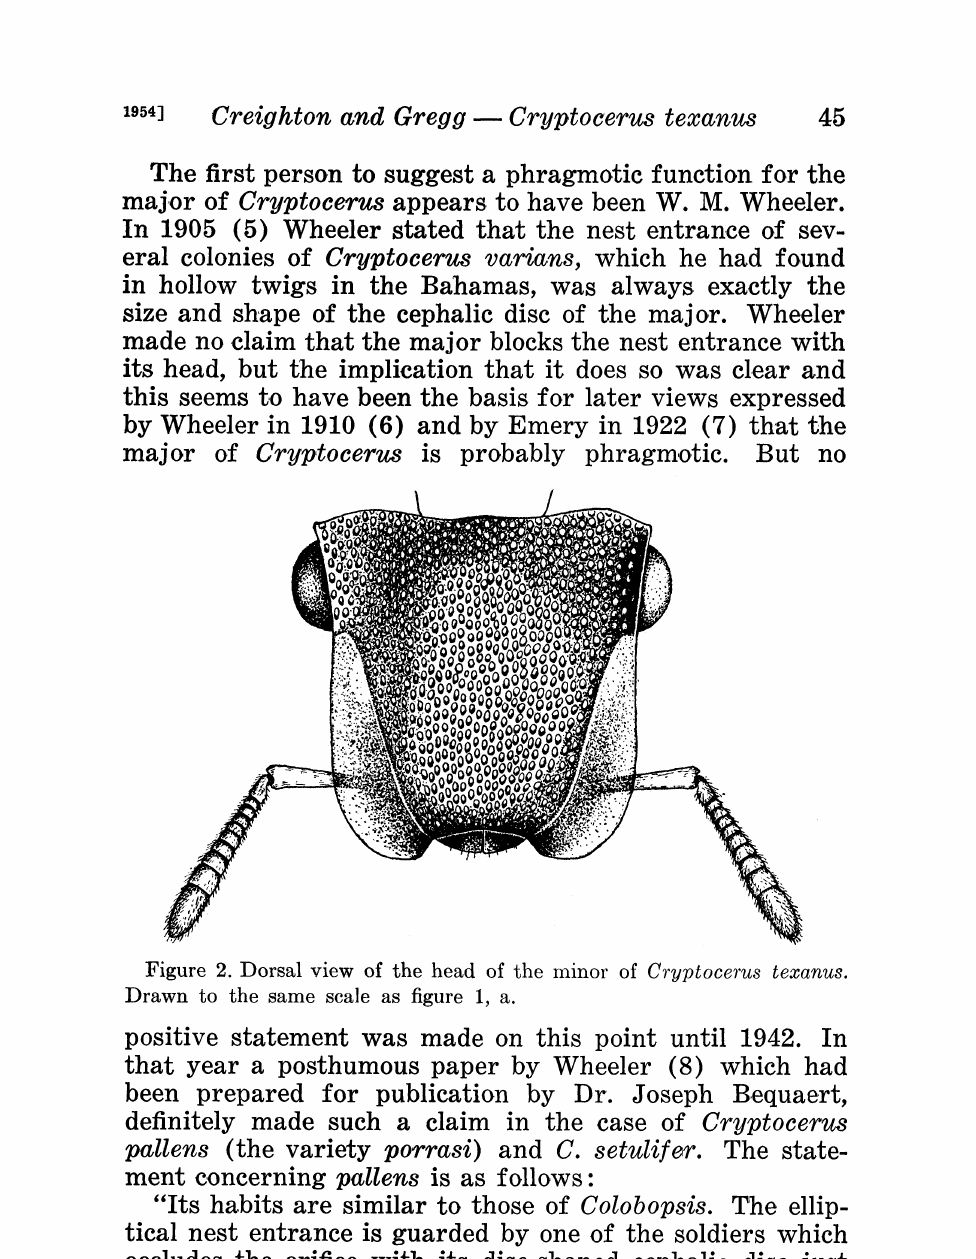
Figure 2. Dorsal view of the head of the minor of Cryptocerus texanus. Drawn to the same scale as figure 1, a. positive statement was made on this point until 1942.